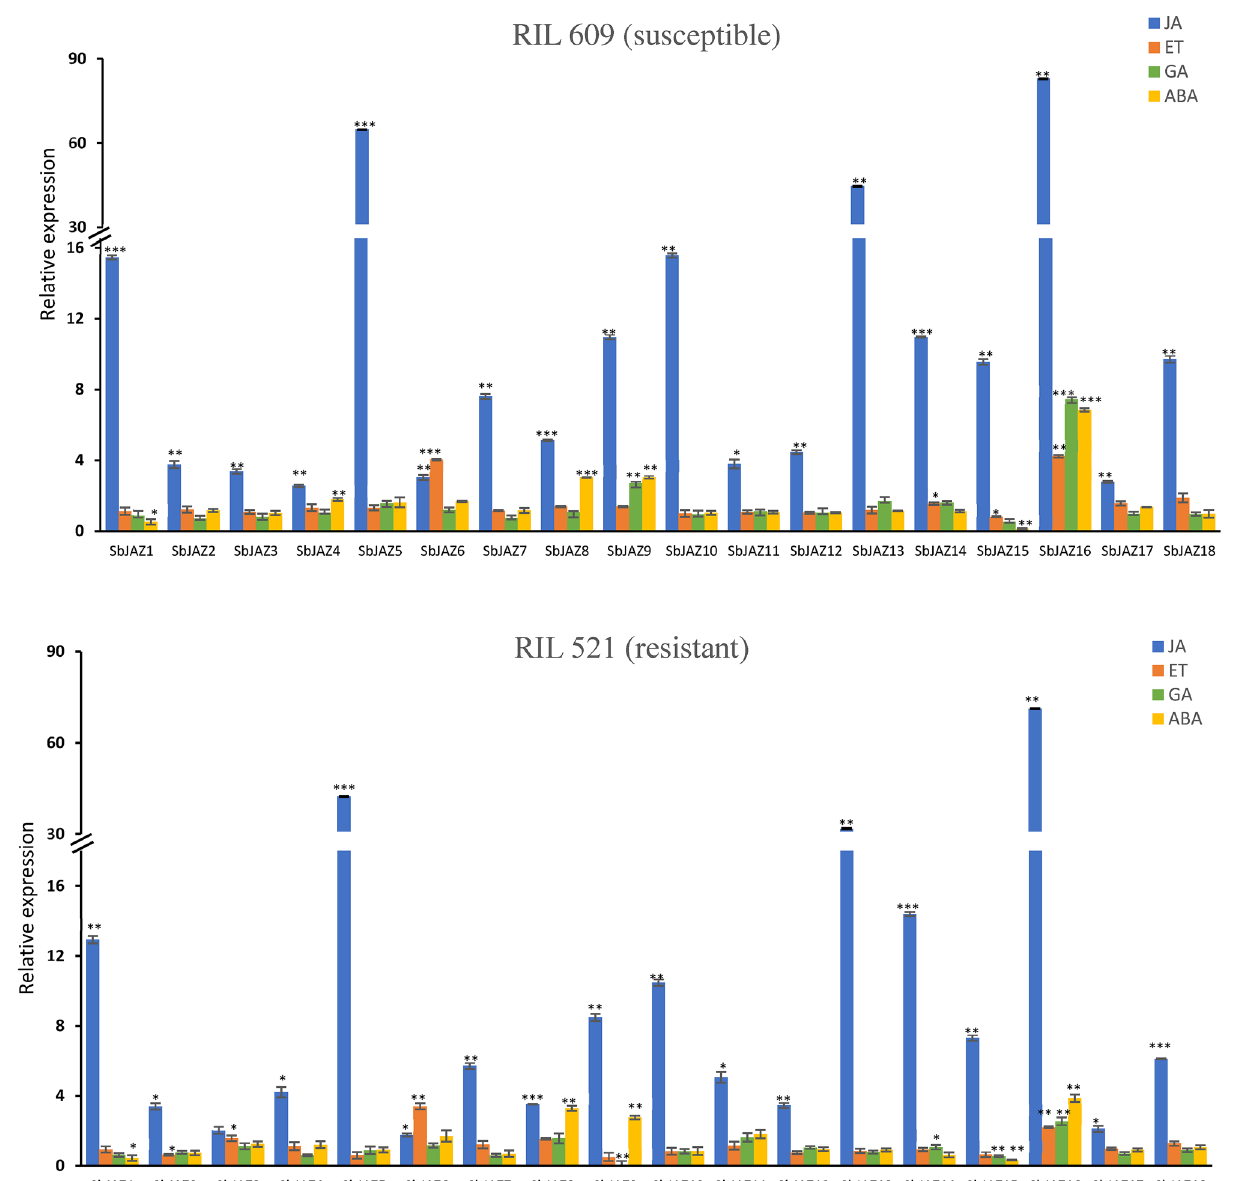
Figure 8. Expression pattern of 18 SbJAZ genes in response to the treatments with phytohormones (JA, ET, GA, and ABA) in resistant (RIL 521) and susceptible (RIL 609) RILs to SCA. qRT-PCR was used to determine the relative expression of each SbJAZ gene, and the relative expression was estimated using the 2 −ΔΔCt method. Error bars in each bar represent the ± standard error (n = 3) and asterisks indicate significant differences between the control and phytohormone treated samples, *P < 0.05, **P < 0.01, ***P < 0.001. The bars without asterisk, are non-significant (P >